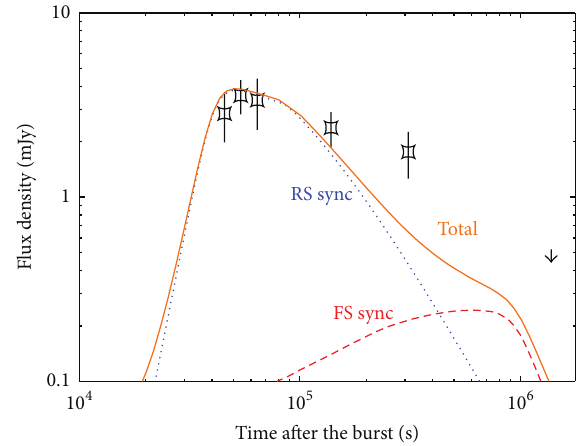
Figure 4: Submm light curve of GRB120326A with RS and FS model